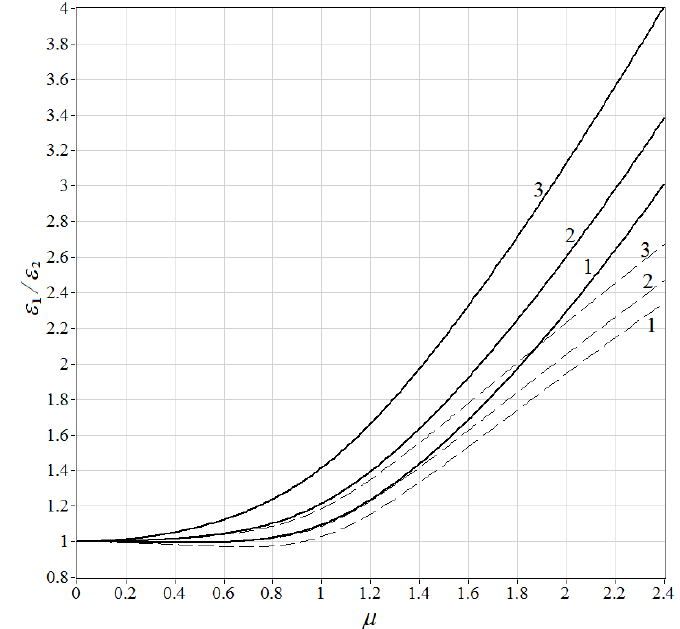
Figure 2. Ratio of lidar estimates of the dissipation rate by Methods 1 and 2 ( ε 1 / ε 2 ) as a function of the ratio of the mean wind velocity to the linear scanning speed ( µ ) at an elevation angle of 16 ◦ (curves 1), 35.3 ◦ (curves 2) and 60 ◦ (curves 3) and ∆ y = 3 m (solid curves) and 12 m (dashed curves).